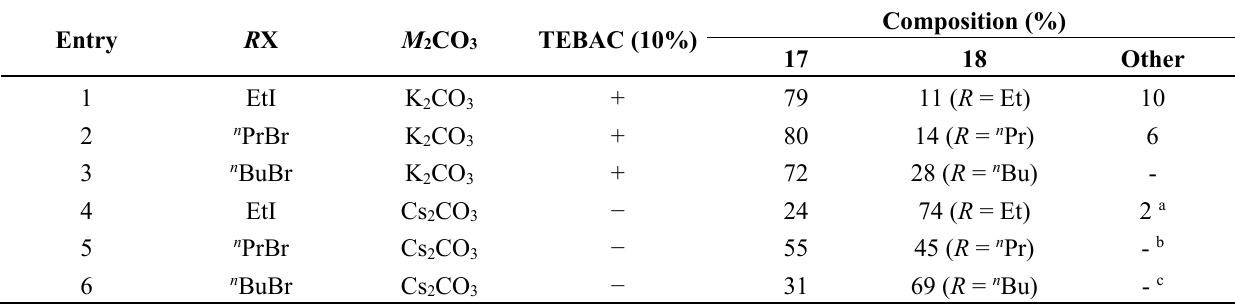
Table 5. Alkylation of diethyl ethoxycarbonylmethylphosphonate ( 17 ) under conventional heating in boiling acetonitrile for 24